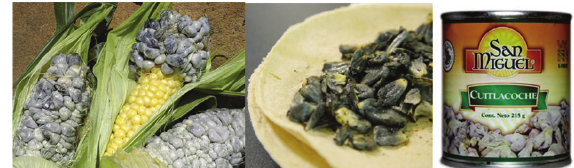
Figure 5: Huitlacoche, the corn smut caused by the fungus Ustilago maydis on